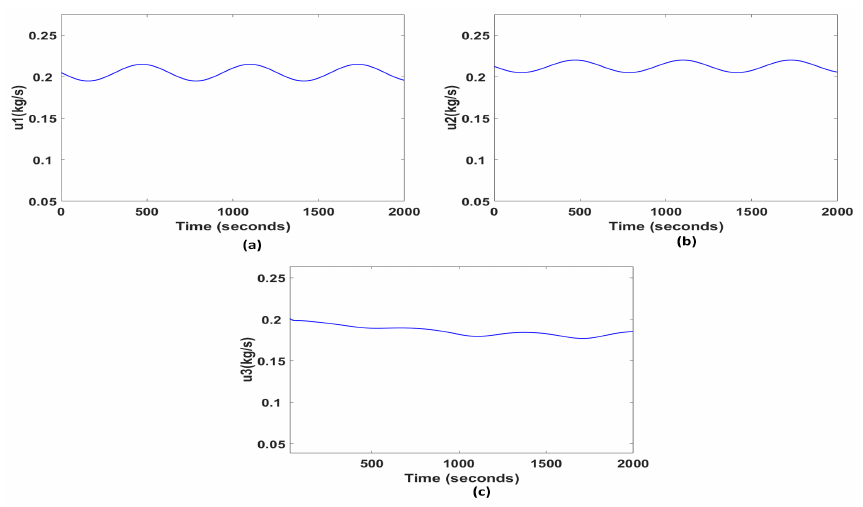
Figure 12. Control efforts: ( a ) u 1 , ( b ) u 2 and ( c ) u 3 by the PID controller for the sine wave reference (Zone 1 and Zone 2).